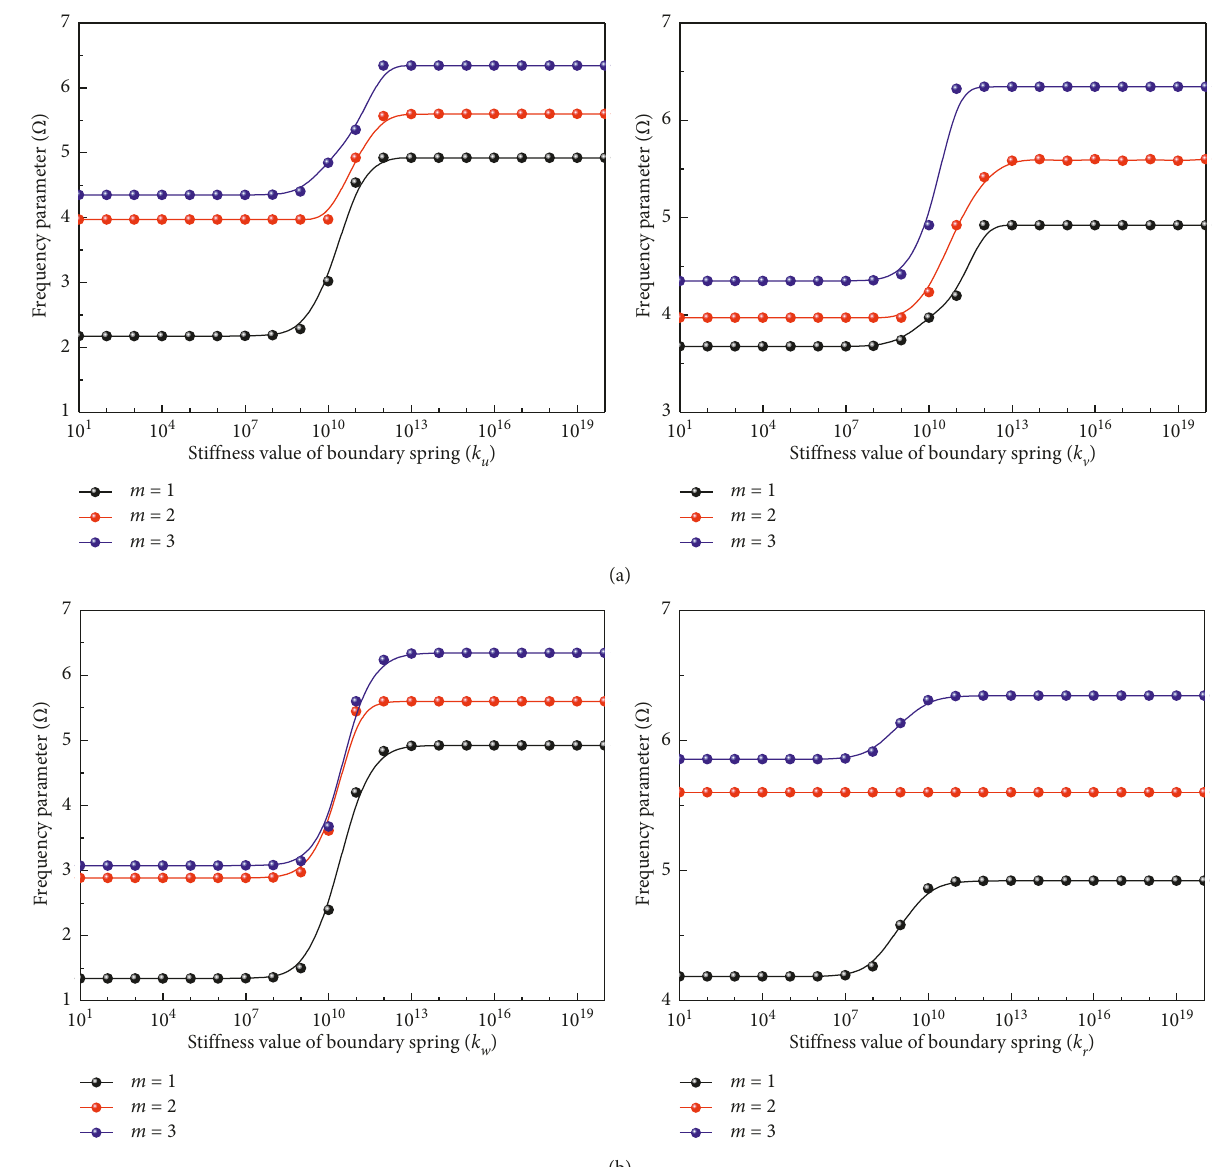
Figure 3: The frequency parameters Ω of type I porous rectangular plate with different boundary spring stiffness values: (a) classical boundary conditions; (b) elastic boundary